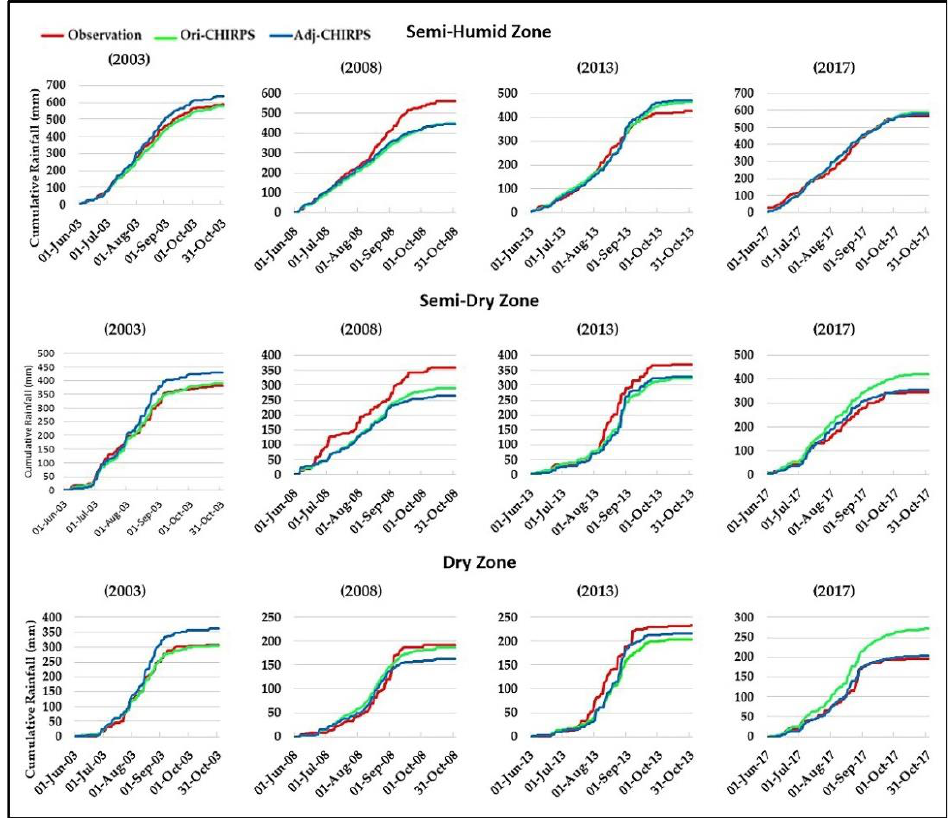
Figure 11. The cumulative rainfall for gauge observations, Ori-CHIRPS, and Adj-CHIRPS.